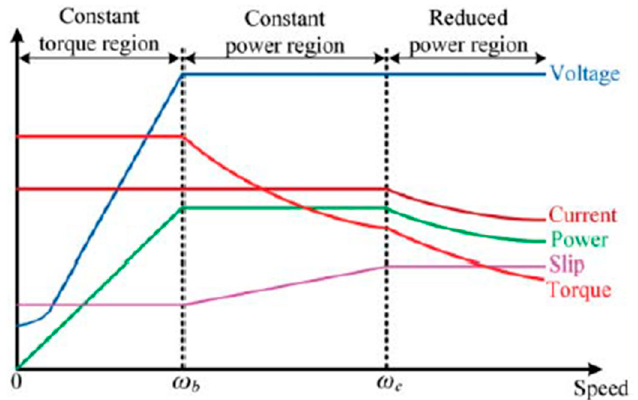
Figure 11. Capabilities of operating VVVF controlled induction motor [78].